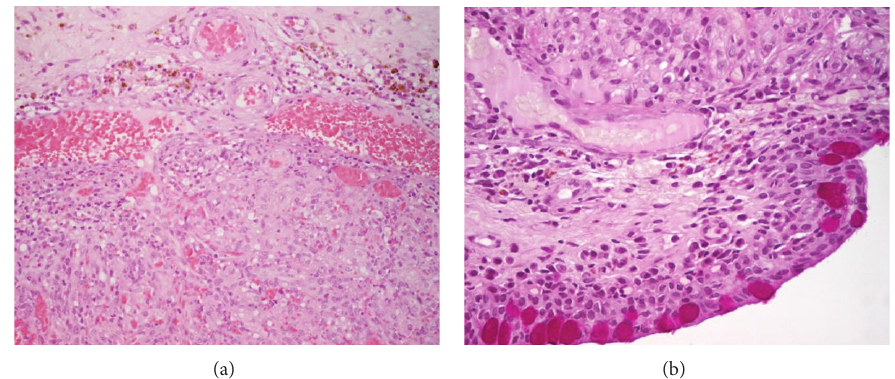
Figure 2: Histopathological finding (a) hematoxylin and eosin stain, (b) peroxide acid-Schiff stain.